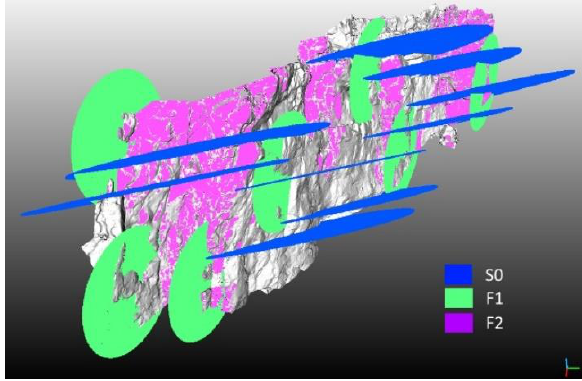
Figure 8. SuperDiscontinuities on the Saulges outcrop